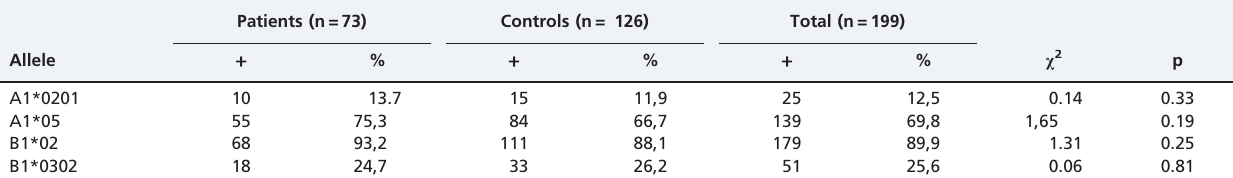
Table 4 - Frequencies of the alleles A1*0201, A1*05, B1*02 and B1*0302 in the patient and control relative groups. Patients Allele